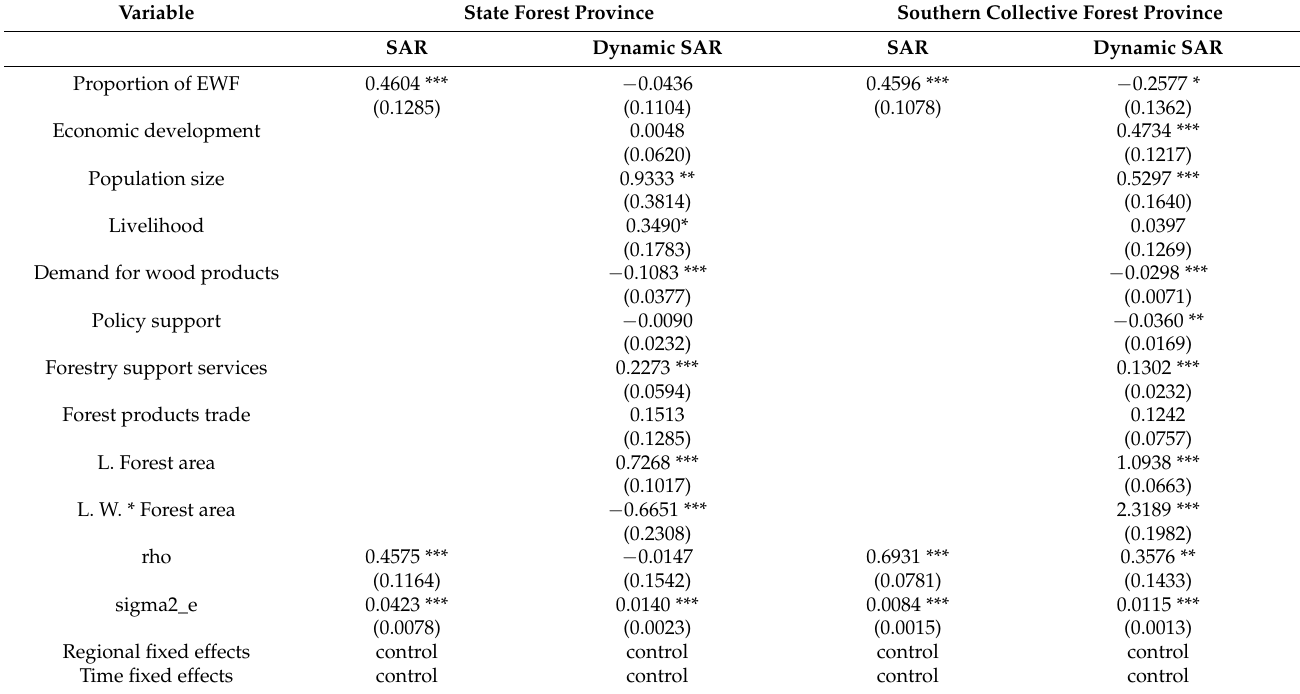
Table 3. Heterogeneity analysis of the different forest